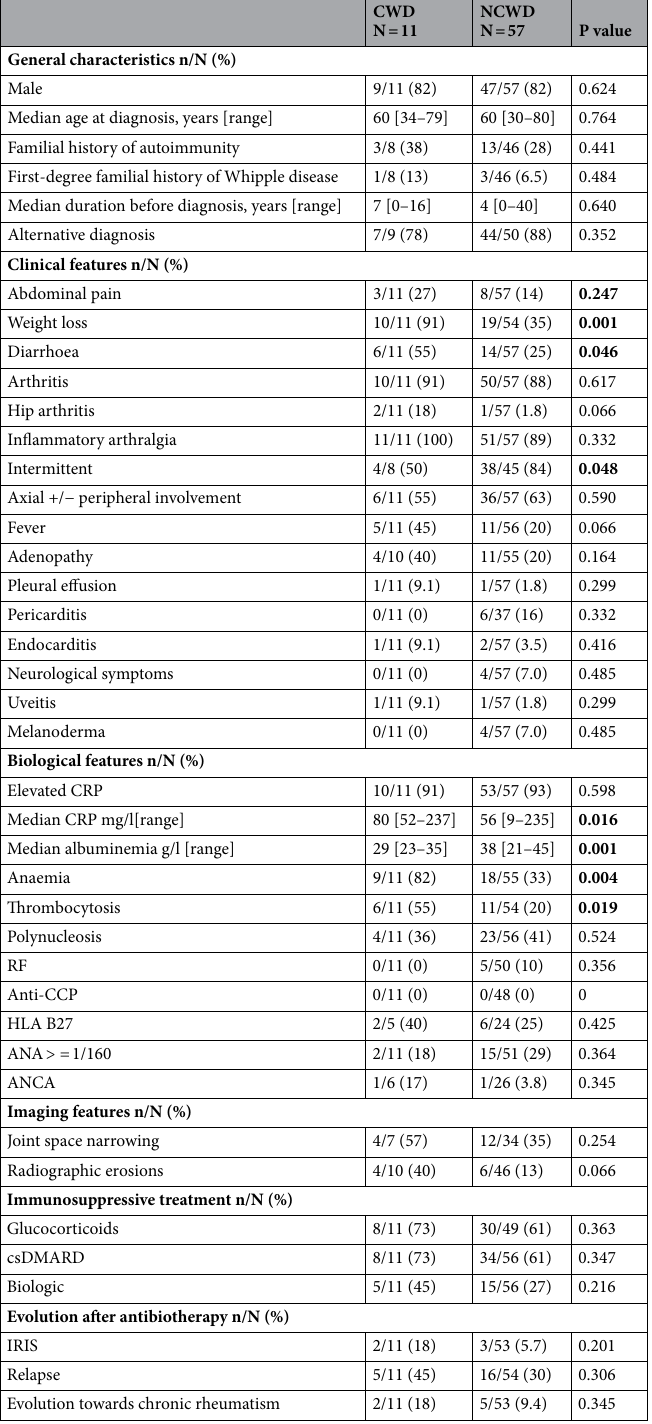
Table 4. General, clinical, biological, imaging and therapeutic features according to classic versus non classic Whipple disease. ANA antinuclear antibodies; CWD classic Whipple disease; csDMARD conventional synthetic disease-modifying antirheumatic drug; IRIS Immune reconstitution inflammatory syndrome; NCWD nonclassic Whipple disease; RF rheumatoid